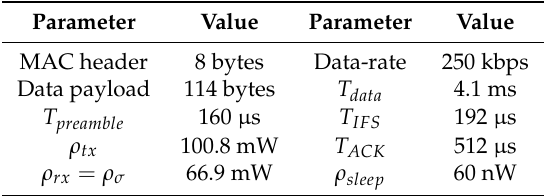
Table 1. System Parameters for FSA-ACK, FSA-FBP and